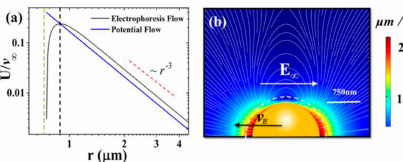
Figure 7. Projected velocity and streamlines in the laboratory frame for a 0.75 µ m radius charge particle under a stationary condition (force balance with no acceleration). The white bars in the figures denote the length scale of 750 nm. ( a ) P 2 projection of the electrophoretic velocity component along the electric field direction, denoted by U normalized by the electrophoresis velocity v ∞ = µ E E , showing very good far-field 1 / r 3 behavior, as indicated by the red dashed line. The yellow dashed line shows the position of the particle surface. The blue line shows the P 2 projection of the Smoluchowski potential flow velocity field. It is clear that the projected 1 / r 3 behavior stops a small distance away from the solid surface. The peak position of the projected result is delineated by the black dashed line, corresponding to the white dashed curve in panel ( b ). ( b ) Streamlines for the negatively charged polystyrene sphere with a = 0.75 µ m (with λ D = 96.1 nm, ka = 7.8, S = − 7000 e / µ m 2 ) plotted in the lab frame. Here, the colors indicate the magnitude of the velocity, while the interface between the inner and outer flow fields (the reference surface) is denoted by the white dashed curve. Adapted from